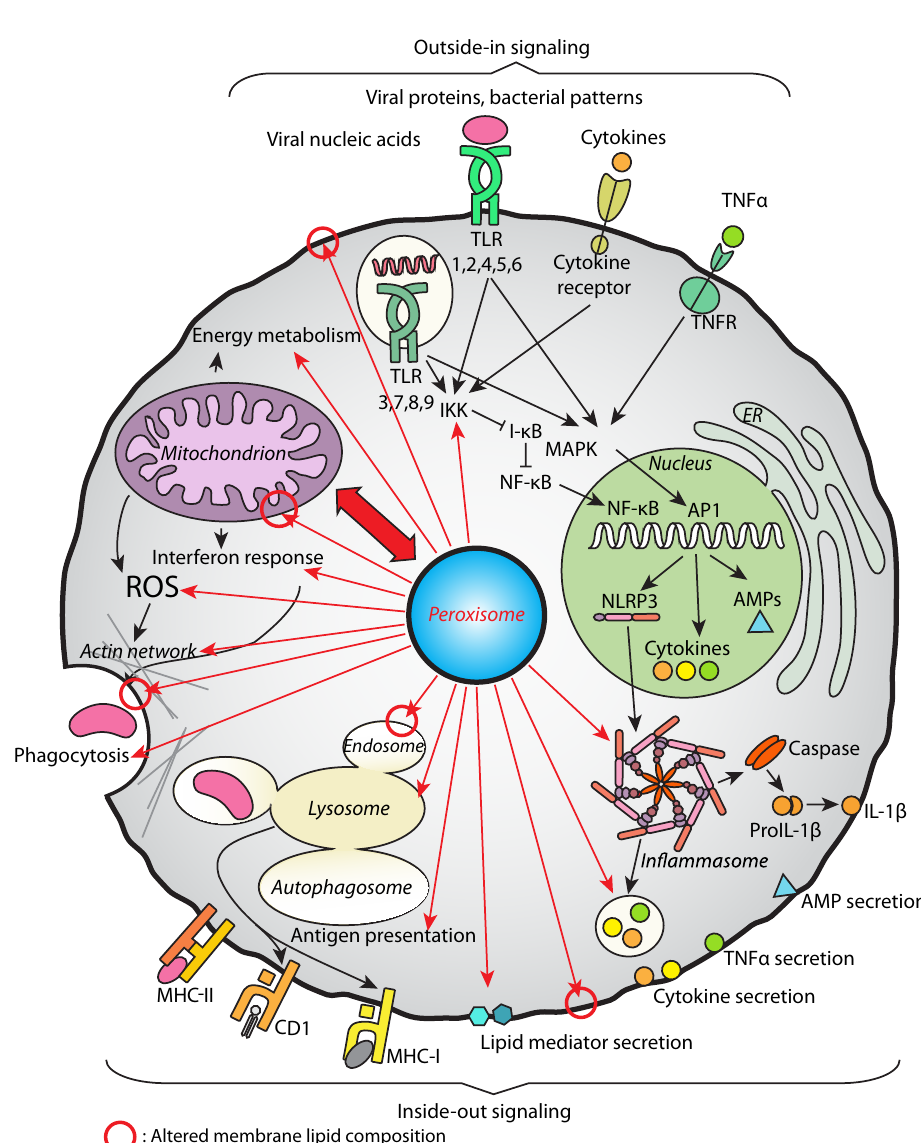
Figure 5. An overview of immune processes regulated by peroxisomes. The overall lipid perturbations in membranes due to peroxisomal defects (indicated by red circles) could impact the function of membrane-localized receptors and signaling between the cells (top: outside-in signaling examples including pattern recognition and pro-inflammatory signals, bottom: inside-out signaling examples including antigen presentation and secretion of immune system mediators). The altered composition of membrane lipids also influences membrane properties relevant for vesicular trafficking (phagocytosis, endocytosis, lysosomal function etc.) and functions of the inner and outer mitochondrial membranes. Peroxisomal functions impact on the immune pathways, like NF- κ B and MAPK, which regulate the production of immune regulators such as cytokines and antimicrobial peptides (AMPs). While a direct link between peroxisomal defects and NLRP3 activation has not been demonstrated so far, peroxisomes may influence the function of the NLRP3 inflammasome. Peroxisomes contribute to the secretion of immune system mediators (like IL-1 β , which is regulated by the inflammasome, but also many other pro- and anti-inflammatory cytokines, including TNF α , and lipid mediators with pro- and anti-inflammatory capacity). Peroxisomes impact on ROS signaling, play a role in phagocytosis regulation (including regulation of the actin cytoskeleton), and in the antiviral interferon-mediated response. Peroxisomes closely cooperate with mitochondria (red double arrow) with respect to membrane contact sites, ROS production, and lipid exchange, thereby influencing energy metabolism and lipid